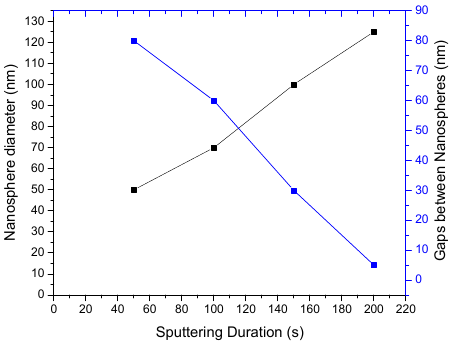
Figure 4. The relationship between the sputtering duration and the size of the obtained nanospheres and the gaps between the nanospheres.